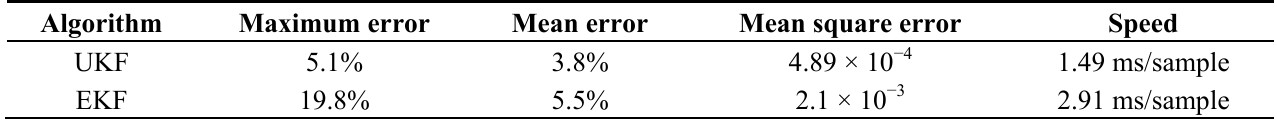
Table 1. Comparisons of the UKF- and EKF-based SOC